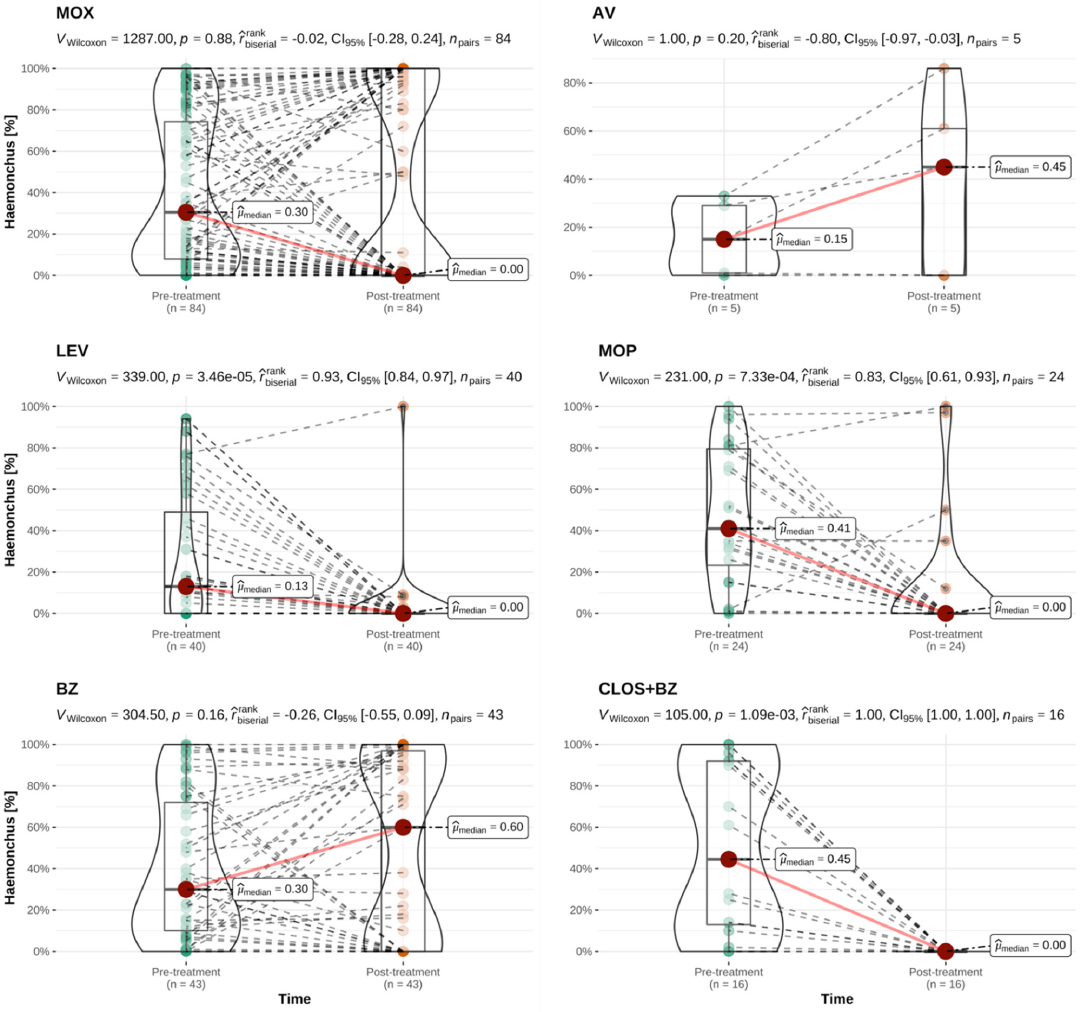
Figure 3. Paired comparison of the pre- and post-treatment percentage of Haemonchus contortus eggs for treatments performed in sheep, by anthelmintic category. This analysis included all ovine treatments irrespective of their classification as successful or unsuccessful. MOX = moxidectin; AV = avermectins, LEV = levamisole; MOP = monepantel; BZ = benzimidazoles; CLOS + BZ = closantel and mebendazole; n = number of flocks treated per category with available paired results. r rankbiserial = effect size with CI 95% = 95% confidence interval; n pairs = number of paired results. Interpretation of r rankbiserial : < 0.05: tiny; ≥ 0.05 and <0.1: very small; ≥ 0.1 and <0.2: small; ≥ 0.2 and <0.3: medium; ≥ 0.3 and <0.4: large; ≥ 0.4: very large [45]. Explanation of scientific notation for p -values: 3.46e-05 and 7.33e-04 are both equivalent to p < 0.001; 1.09e-03 is equivalent to p = 0.001.